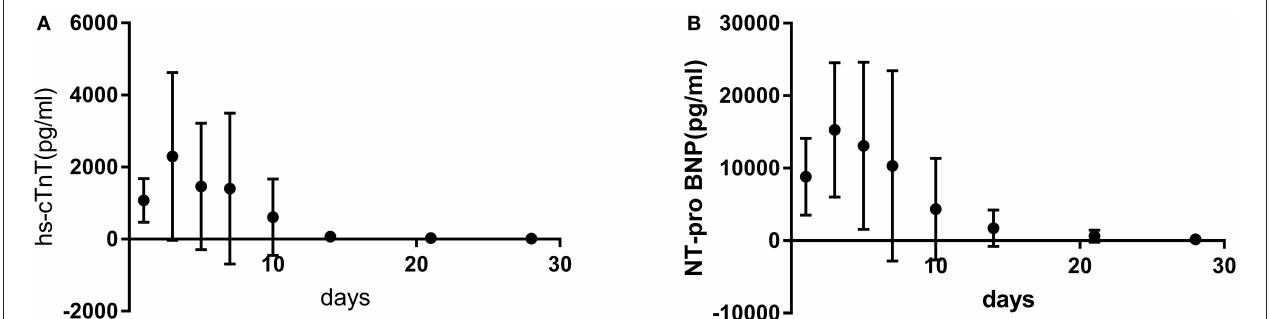
FIGURE 1 | The trend of hs-cTnT (A) and NT-pro BNP (B) with the course of disease.